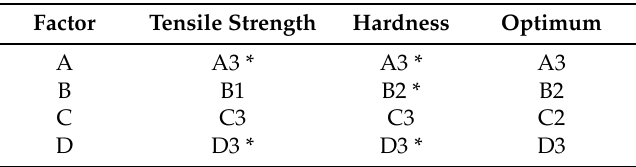
Table 8. Optimum condition table for spheroidized annealing.